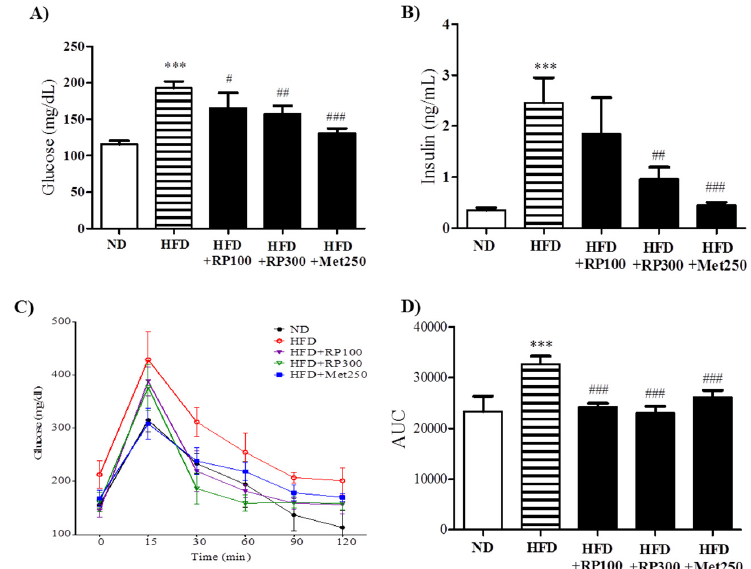
Figure 4. Effects of RP extract on glucose tolerance and insulinemia. ( A ) Fasting serum glucose; ( B ) Serum insulin; ( C ) Oral glucose tolerance test (OGTT); ( D ) Area under the curve in OGTT. Results are presented as means ± standard errors of the mean (SEM) ( n = 5). *** p < 0.001 vs. the normal chow fed controls (ND group); ### p < 0.001, ## p < 0.01, # p < 0.05 vs. the HFD mice. RP, Radix Pueraria lobata ; ND, normal diet; HFD, high fat diet; AUC, area under the curve.